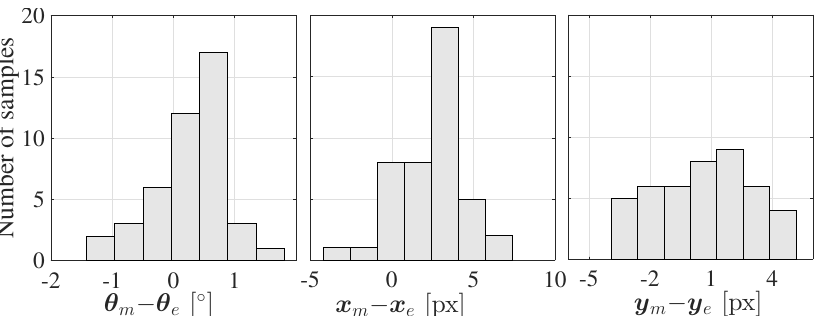
Figure 10. Femur configuration estimation